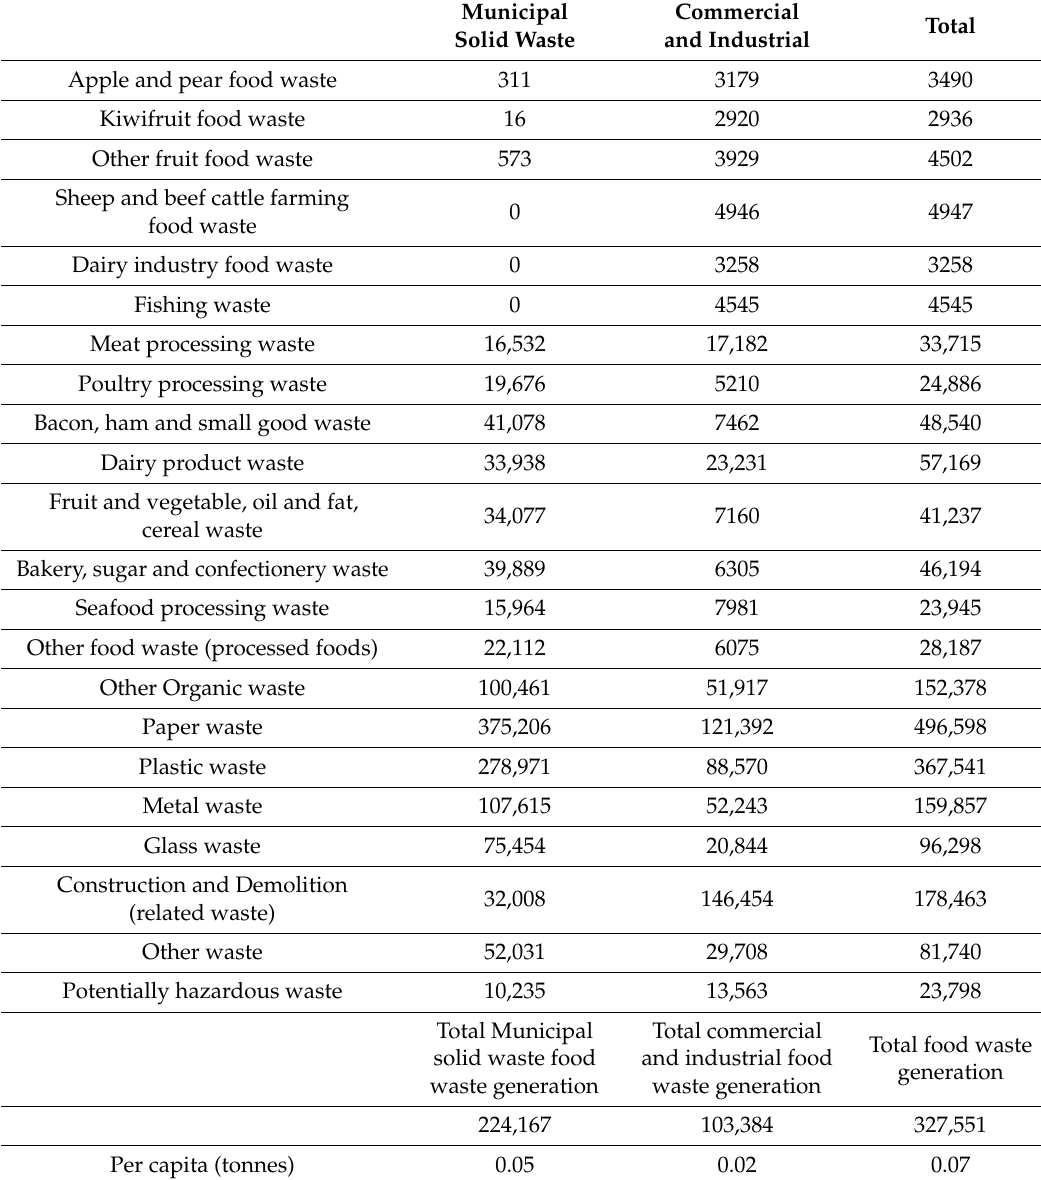
Table 1. Tonnages of waste generation in New Zealand in